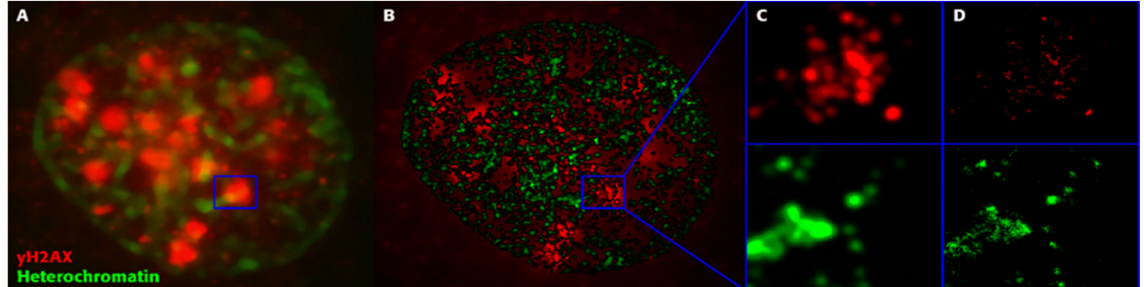
Figure 6. Superresolution imaging of a breast cancer (SkBr3) cell during DSB repair after exposure to 1 Gy X-rays. From such images, characteristic molecular arrangements during repair are elucidated. ( A ) Overview image acquired by widefield microscopy. The blue square (2 µ m × 2 µ m) encloses a typical γ H2AX focus. ( B ) Superresolution SMLM image of heterochromatin (green) and γ H2AX foci (red), with the γ H2AX overview image in the background indicating the reduced z-slice depth in the SMLM image reconstructed from the label point coordinates. ( C ) Magnification of the marked region (2 µ m × 2 µ m) in the SMLM image with Gaussian blur but without the background image; the two color channels are separated in the upper and lower images. ( D ) The same image as ( C ) but with maximum precision of label points (each point corresponds to a single fluorescent molecule of the indicated antibody). Maximum precision means the highest image resolution that can be obtained from the SMLM data set. (Note: In all images, the blue squares enclose an area of 2 µ m × 2 µ m and can be used as scale